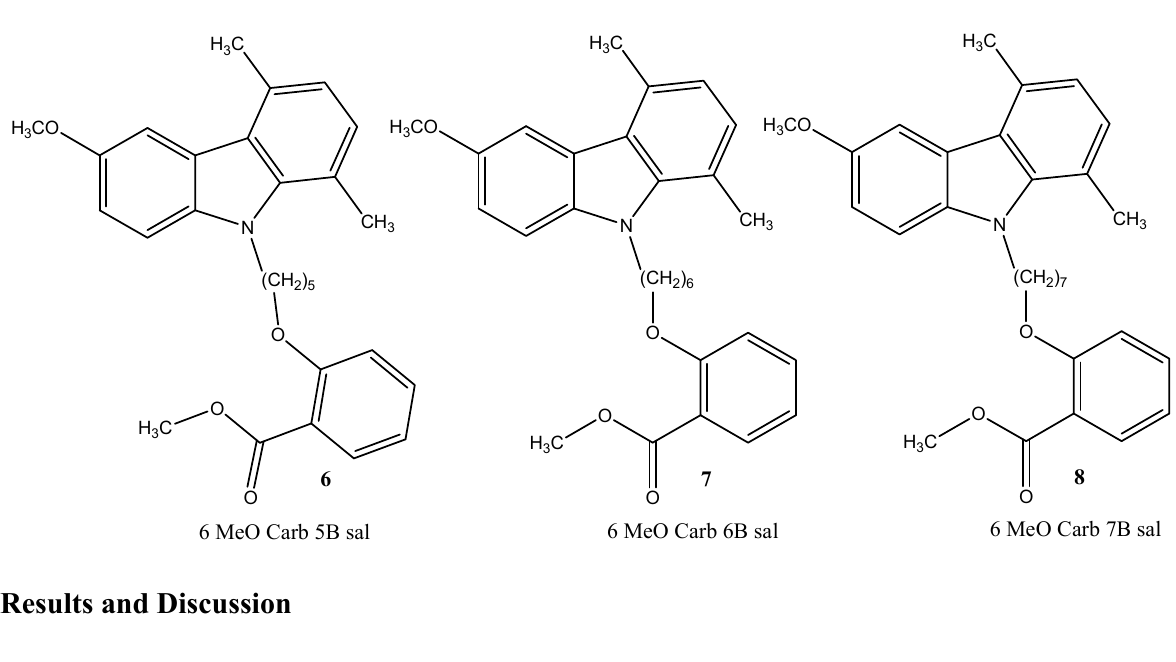
Figure 2. N -alkyl 1,4-dimethyl-carbazole